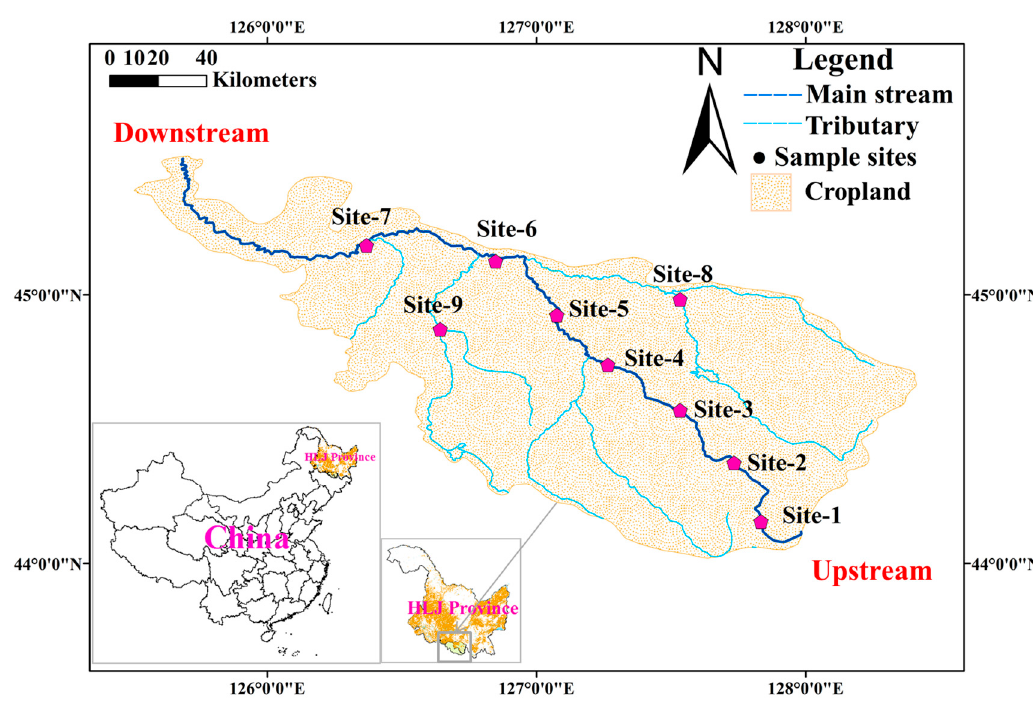
Figure 1. The location of sampling stations in Lalin River Basin.